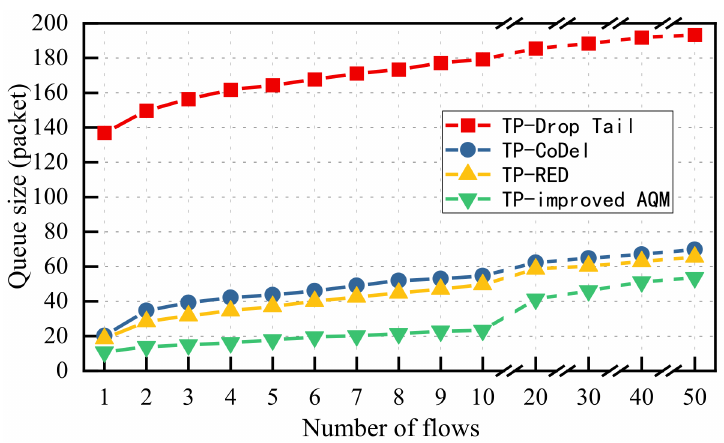
Figure 10. The average queue length under different numbers of ICN flows.